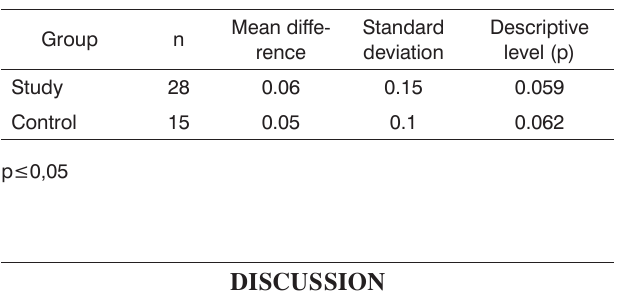
Table 7. Comparing the optokinetic nystagmus gain to the right and to the left in the study and control groups